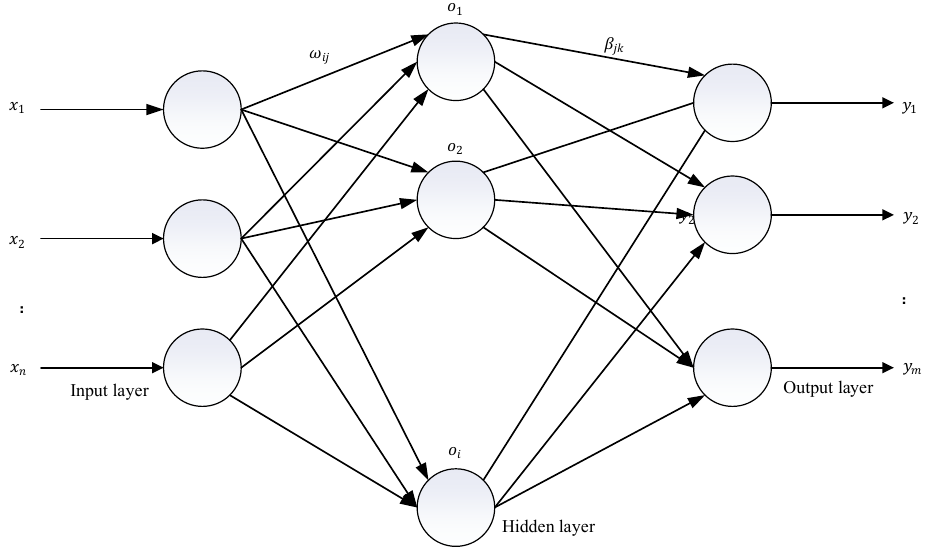
Figure 2. Single hidden layer feedforward network structure.